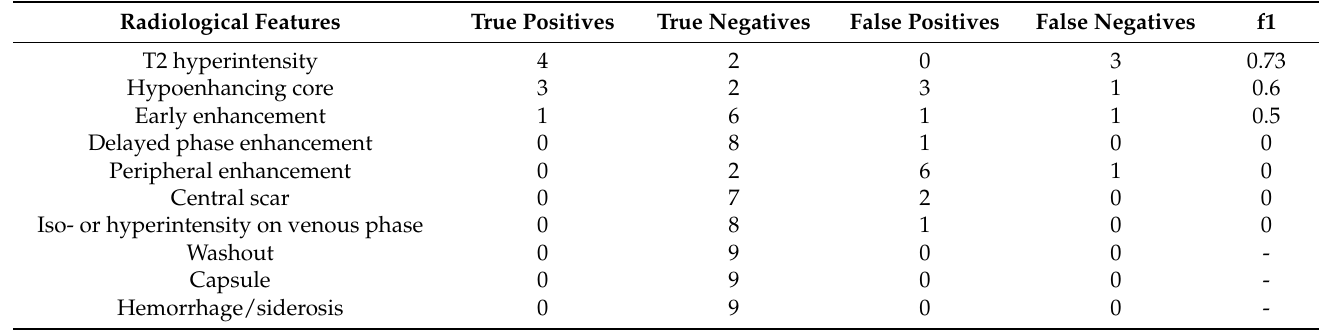
Table 7. Results for annotated features: other lesions.